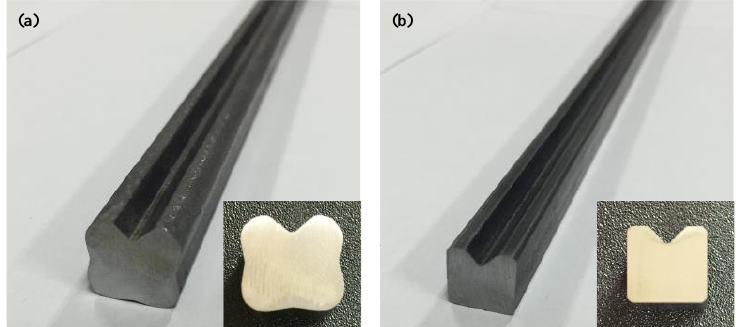
Figure 15. Drawn material in each pass for the cross-roller guide: ( a ) first pass; ( b ) second pass.